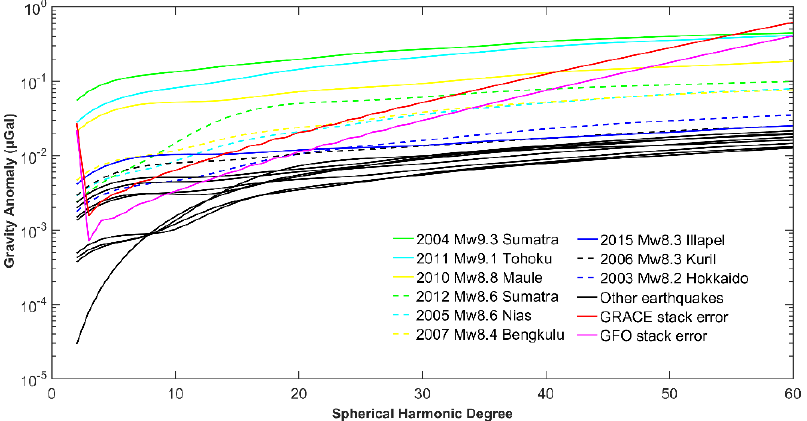
Figure 4. Degree amplitude spectra for GRACE/GFO stack error and model-predicted coseismic gravity of earthquakes above Mw8.0 during GRACE mission.